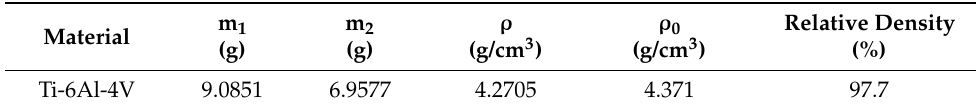
Table 5. Results of relative density.